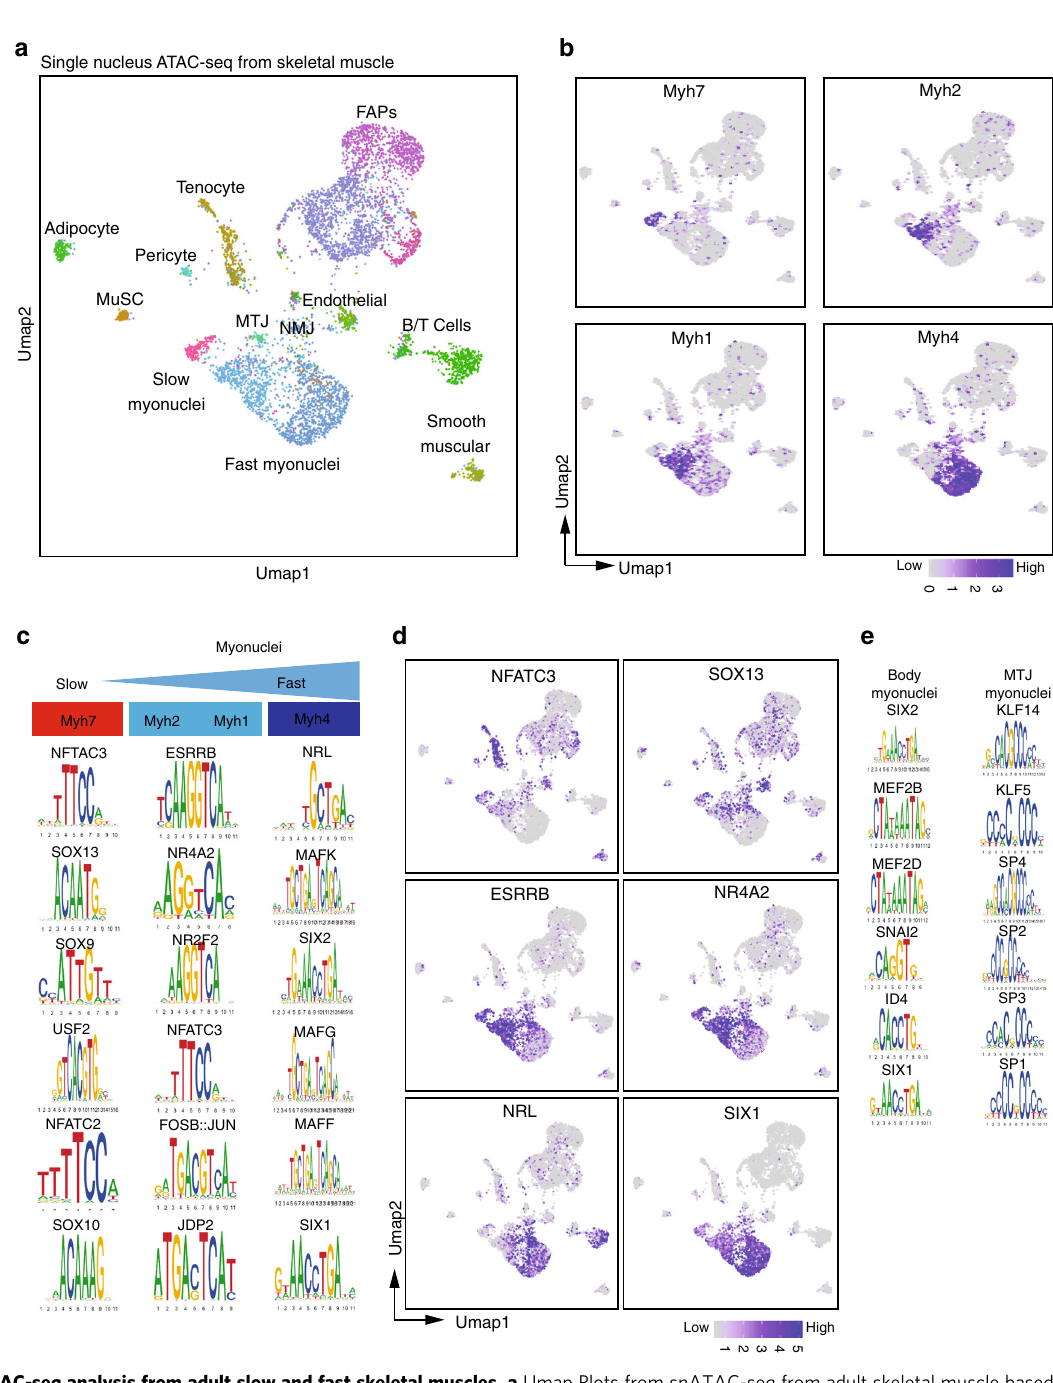
Fig. 3 SnATAC-seq analysis from adult slow and fast skeletal muscles. a Umap Plots from snATAC-seq from adult skeletal muscle based on chromatin accessibility. MuSC skeletal muscle stem cells, FAPs fi bro-adipogenic progenitors, MTJ myotendinous junction, NMJ neuromuscular junction. b Umap plots showing the chromatin opening of slow and fast Myh genes used to identify the different types of myonuclei. The intensity of the blue color re fl ects the level of chromatin accessibility of the gene. c Position weight matrix (PWM) motifs showing the enrichment of TF motifs in differential peaks in the myonuclei expressing the different Myh genes. d Umap Plots showing the motif activity of TF in the different types of myonuclei. The intensity of the blue color re fl ects the level of TF motif enrichment in the nuclei. e PWM motif showing the enrichment of TF motifs in differential peaks in the body and MTJ